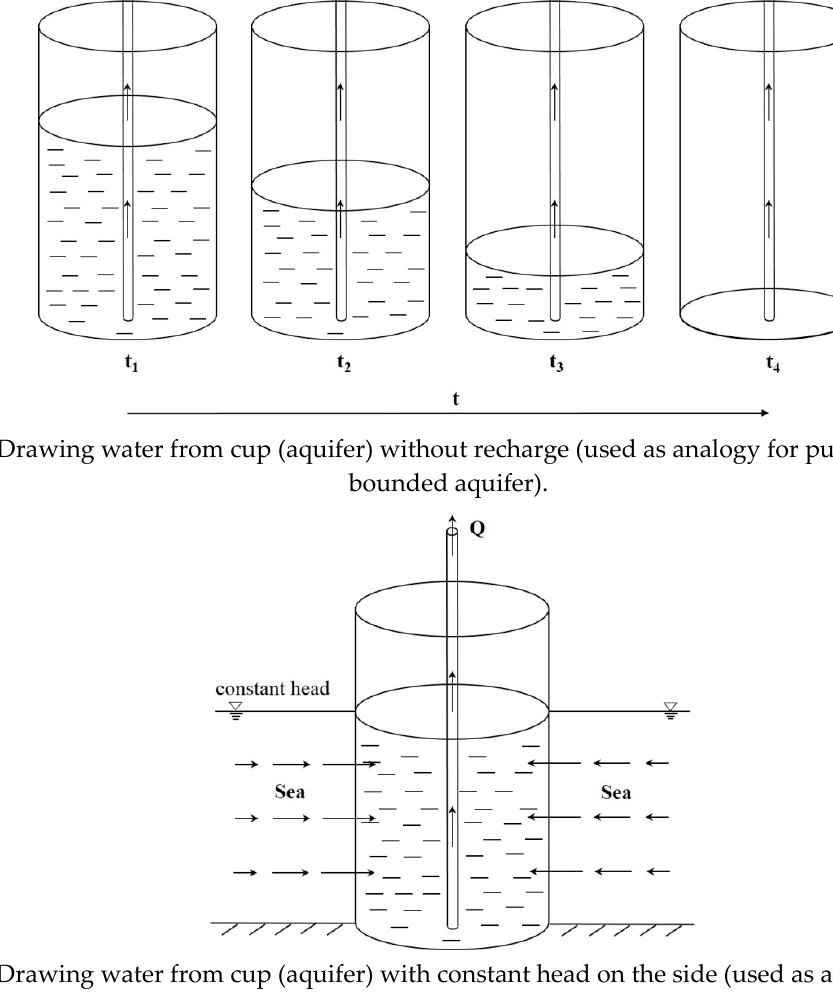
Figure 7. Drawing water from cup (used as analogy for pumping in bounded aquifer). Q is the water yield of the pumping well, [L 3 T − 1 ]; and t is the time, [T].